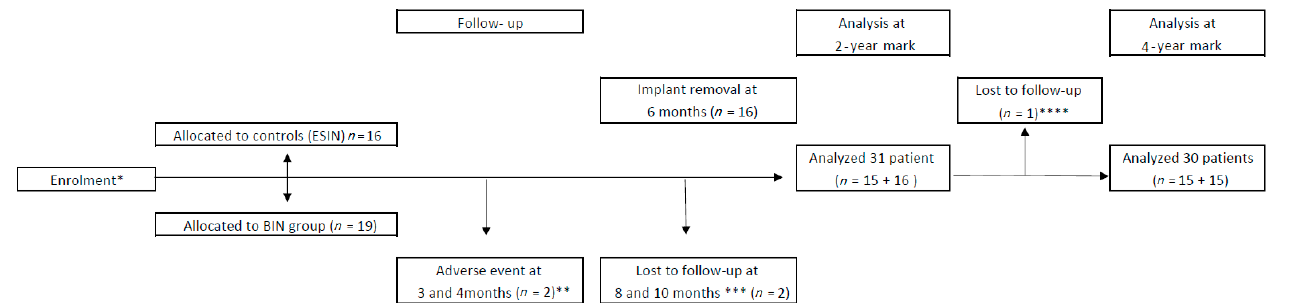
Figure 1. Flow chart of the randomized controlled trial in children with forearm shaft fractures treated either via bioab- sorbable nailing (BIN) or elastic stable intramedullary nailing (ESIN). * The enrolment occurred between November 2011 and January 2015. ** Two patients suffered from implant failures. *** Two patients had high-energy injuries resulting in new forearm fractures. **** One patient was not attending because of a serious illness.